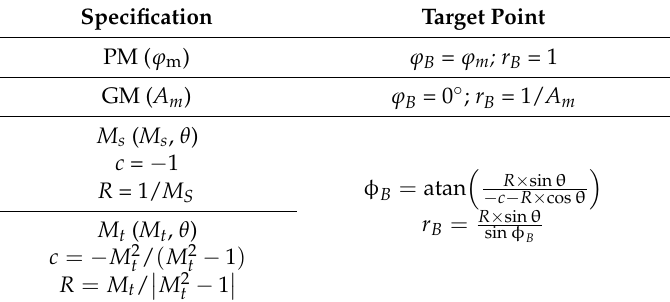
proportional-integral-derivative (PID) α control of the non-minimum phase process in Equation (5).